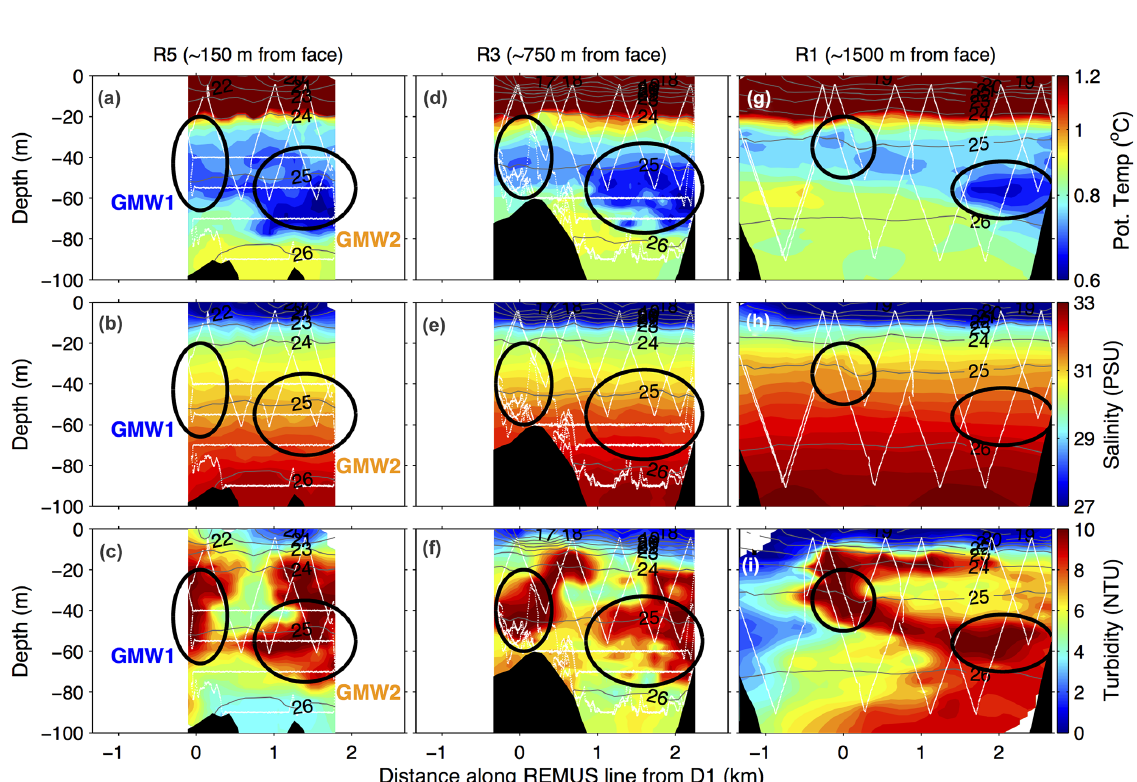
Figure 4. Select REMUS across-fjord sections. θ ( ◦ C), S (PSU), and turbidity (NTU) sections along REMUS lines (a) – (c) R5, (d) – (f) R3, and (g) – (i) R1 from 0 to 100m depth. Sections are oriented looking away from the terminus, with the southwestern end of the section on the left. Across-fjord transect distance is plotted as horizontal distance along section, with 0km located at the intersection of the REMUS section with an along-fjord line running from D1 to the southwestern LBL transponder along R1 (Fig. 3). GMW1 and GMW2 regions identified by black ellipses, and labeled in blue and gold, respectively in (a) – (c) . Isopycnals plotted in grey, REMUS mission tracks shown in white (Table 1), and bathymetry shown in black (Fig.